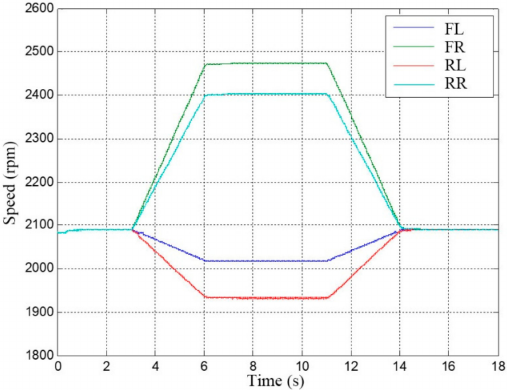
Figure 15. The non-loaded SRM speed at 15 ◦